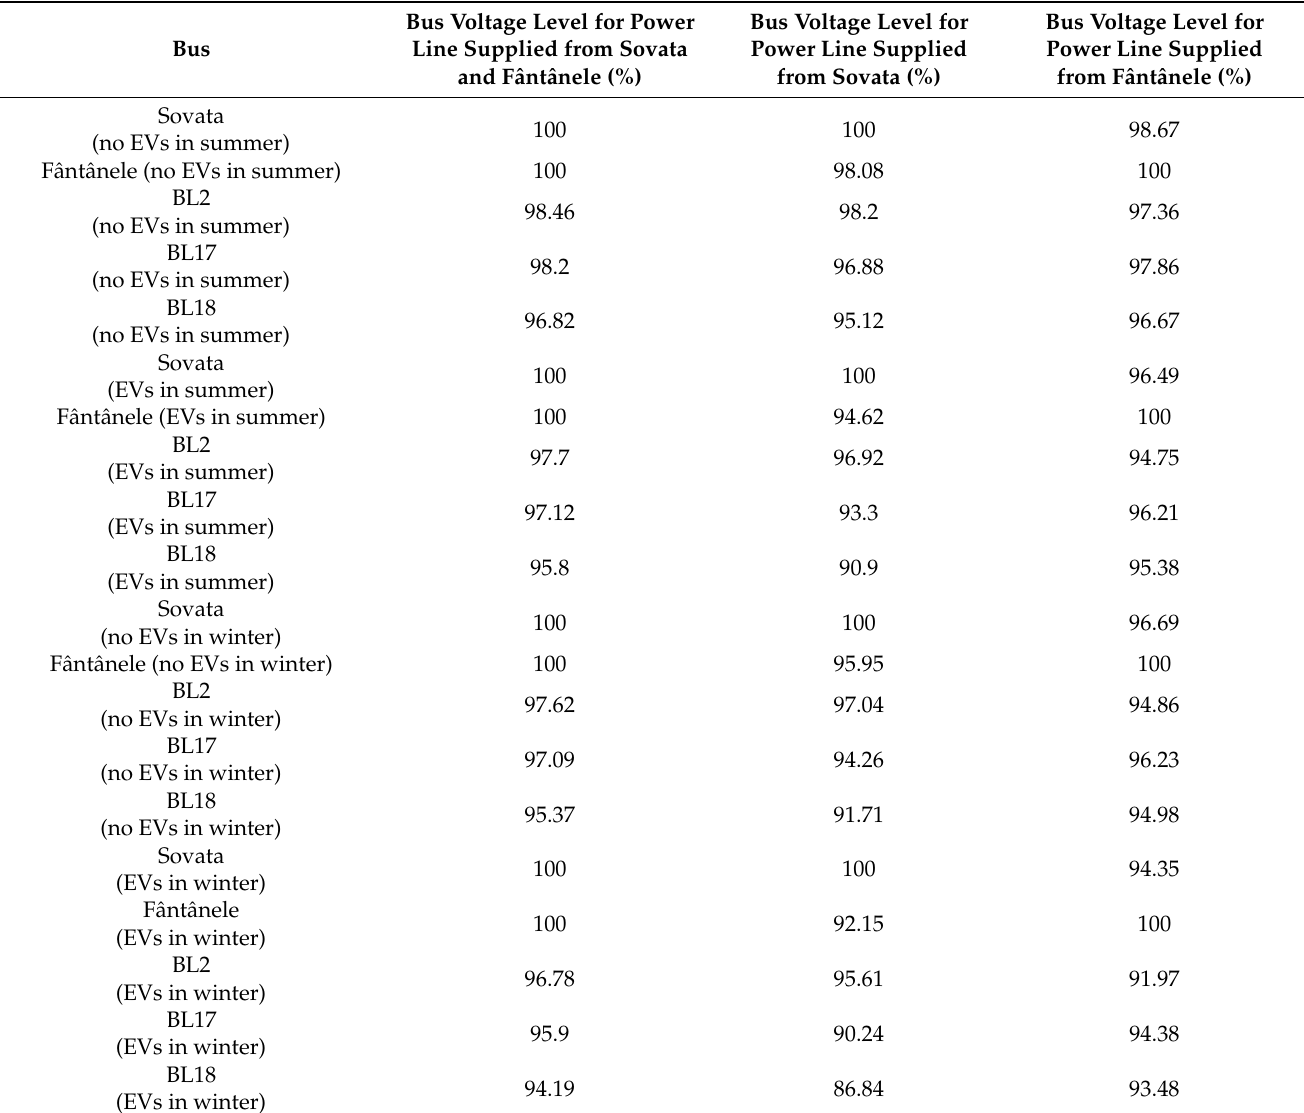
Table 26. Voltage level at 15:00 (scenario